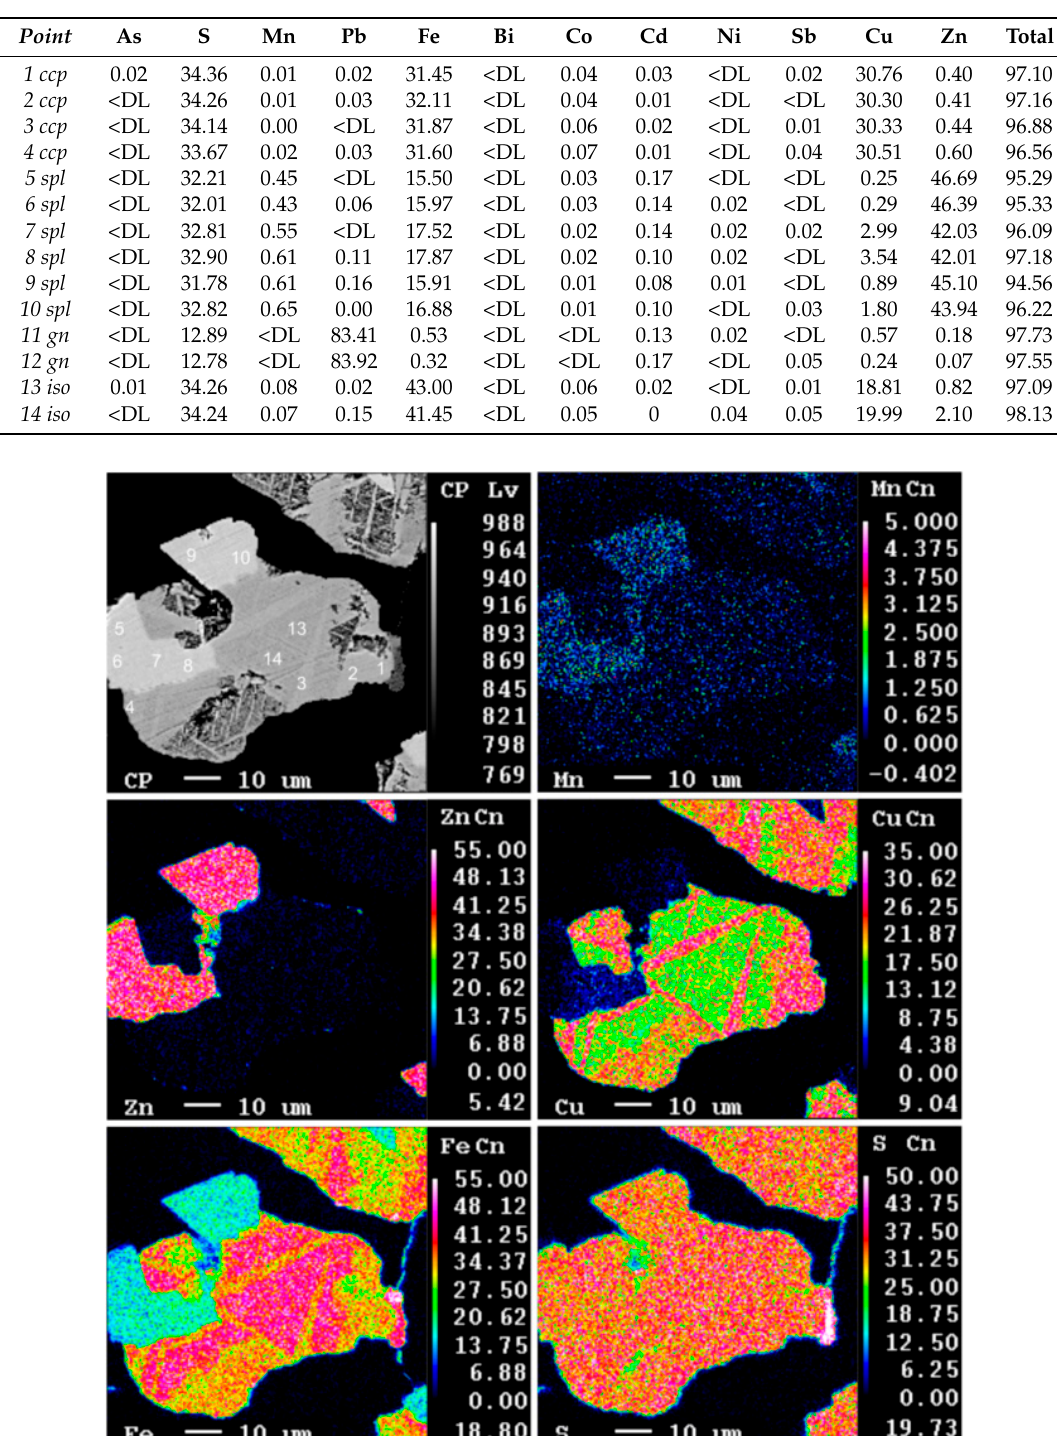
Table 4. Electron probe micro-analysis (EPMA) point analyses with mineral identification and elemental wt %. Mineral abbreviations after [43]. iso is isocubanite. Point locations are indicated in Figure 7. Points 11 and 12 are from an adjacent galena crystal. Element detection limits (ppm) are provided for each analysis point in Appendix A, Table A1.